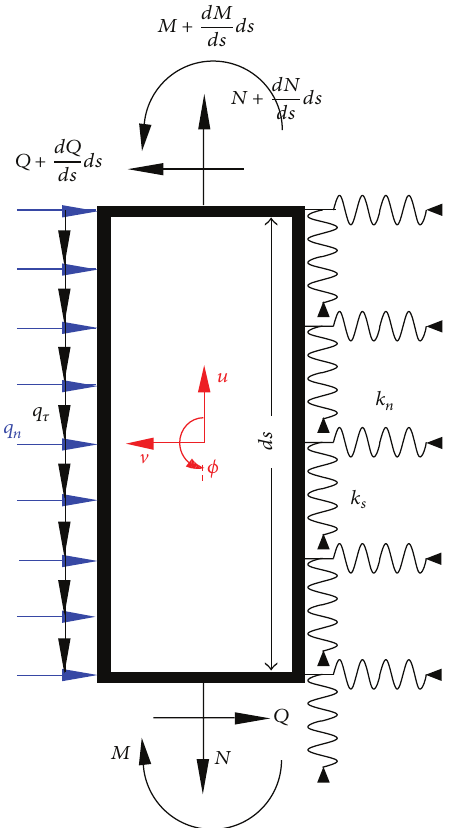
Figure 2: The free-body diagram of infinitesimal isolated segment of